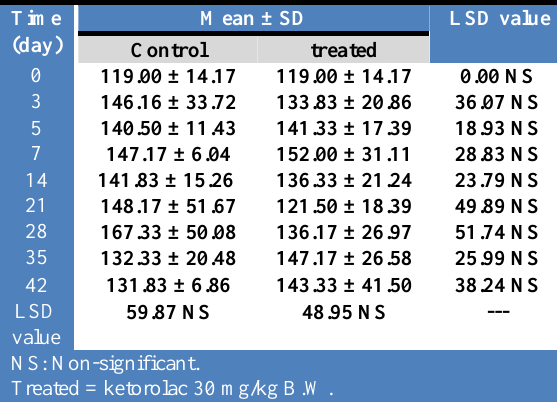
Table, 13: Shows Blood sugar (mg/dl) in control and treated